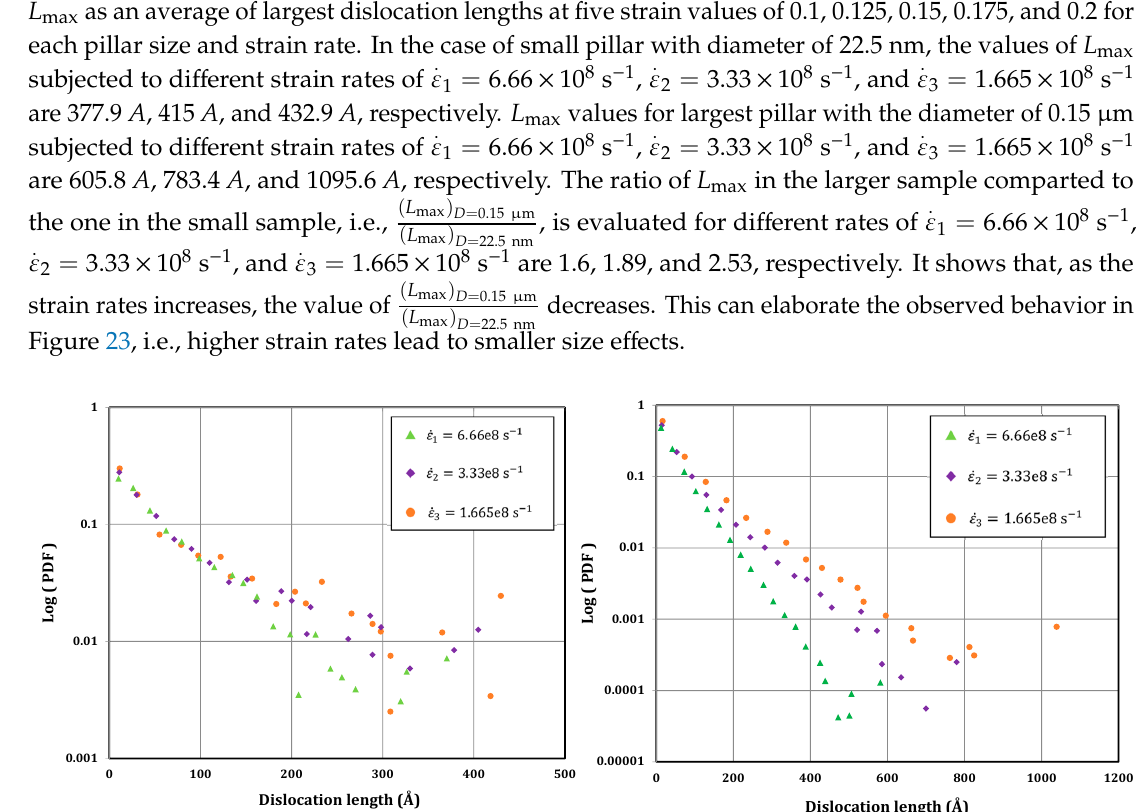
Figure 24. Probability distribution function of dislocation length at different strain rates and pillars with the diameters of: ( a ) D = 45 nm; ( b ) D = 150 nm (after Voyiadjis and Yaghoobi [16]).